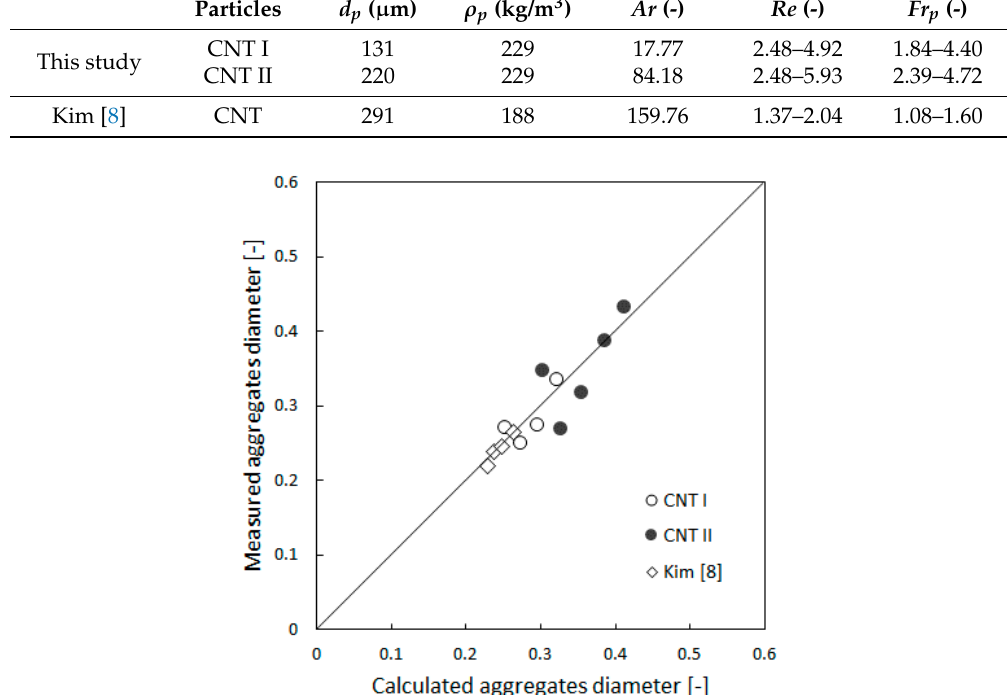
Figure 10. Comparison of the calculated Heywood diameter of aggregates and the experimental data.